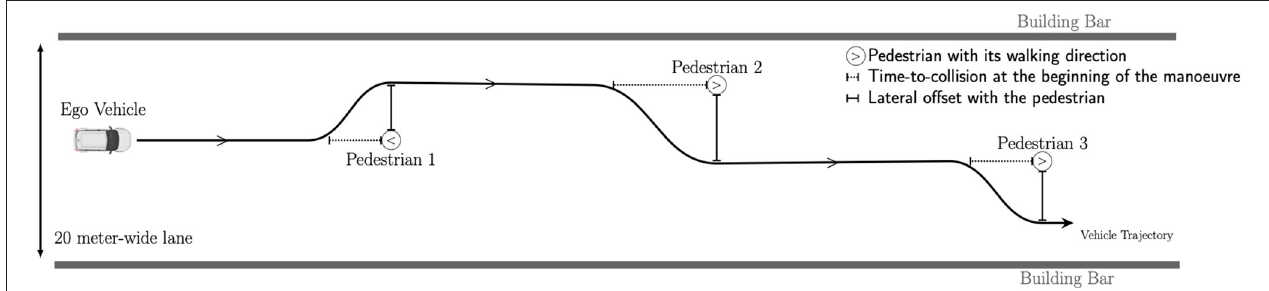
FIGURE 1 | Sample diagram of the vehicle trajectory among pedestrians. The combination of the two factors (TTC and offset) varied between pedestrians according to the experimental plan, which was identical for all the participants. The pedestrians’ walking directions and the lateral directions of the avoidance manoeuvres are also